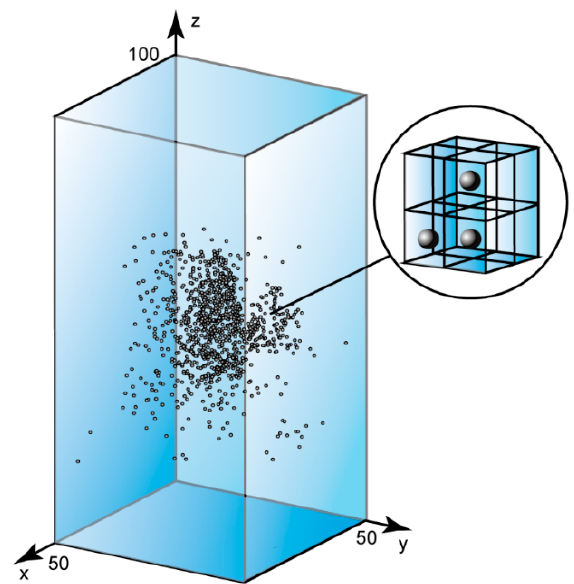
Figure 8. One typical spatial distribution of AE location hypocenter for non-tectonic, and there are 1051 hypocenters have been captured in this sample. Since grids are too dense, the large figure does not show cells. The inset shows AE centers and cubic unit cells with grids. (Unit: mm).